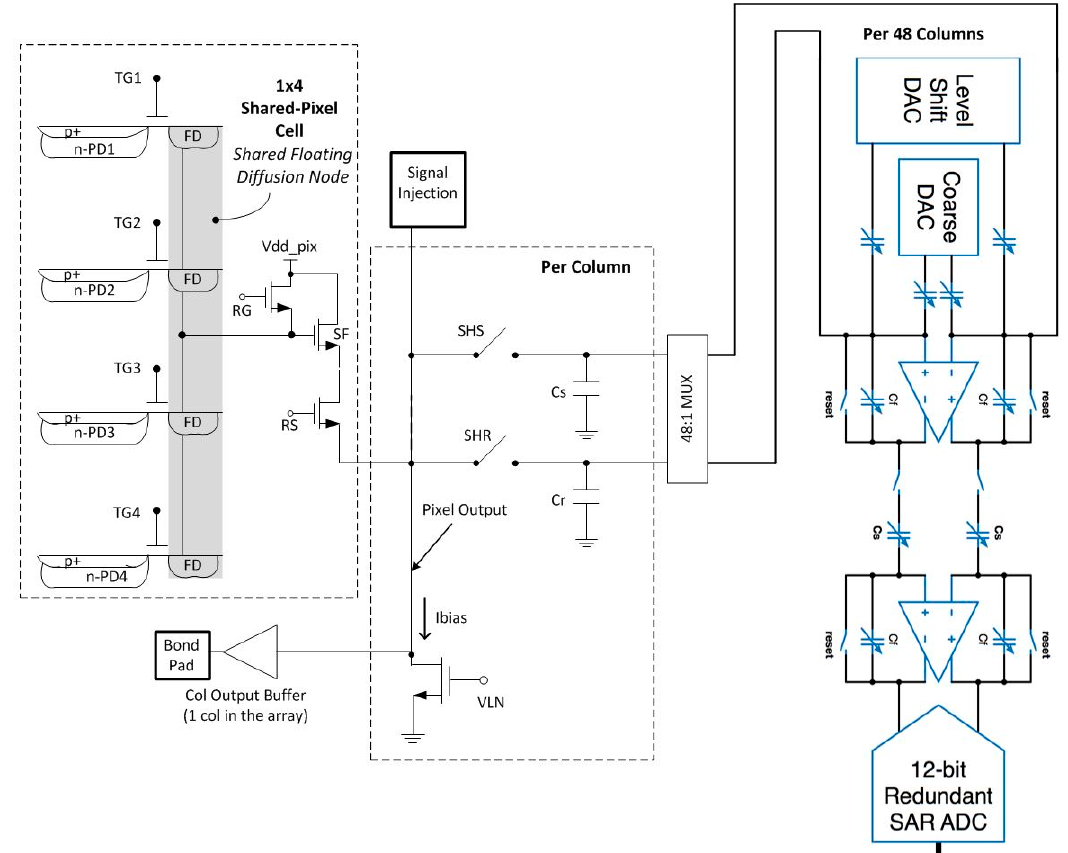
Figure 5. Block diagram of pixel array and readout signal path.